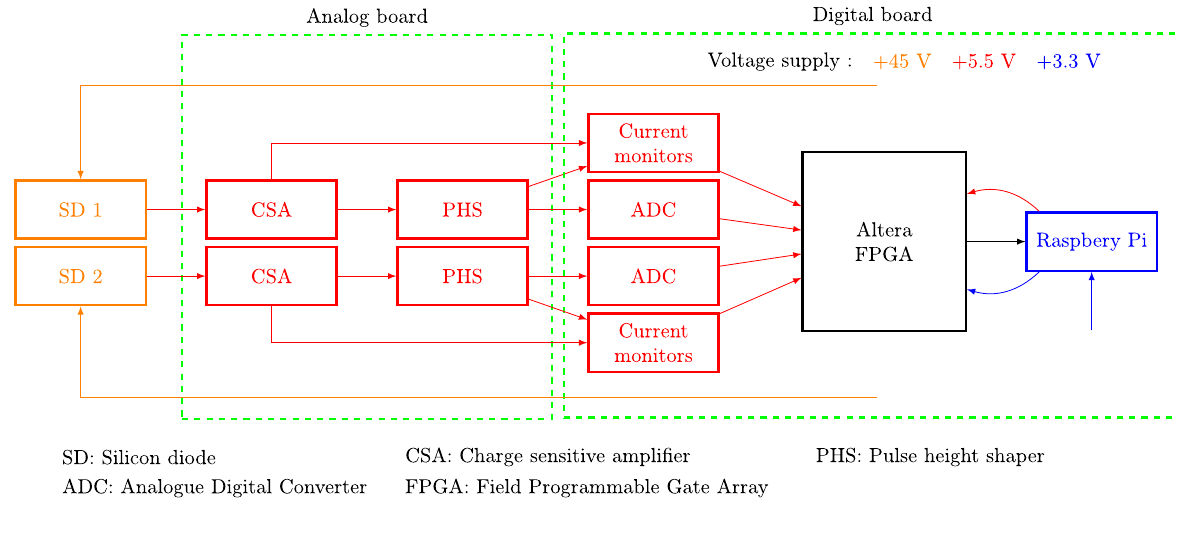
Figure A.1. Schematic representation of the RPiRENA detector, divided into an analogue and a digital part.